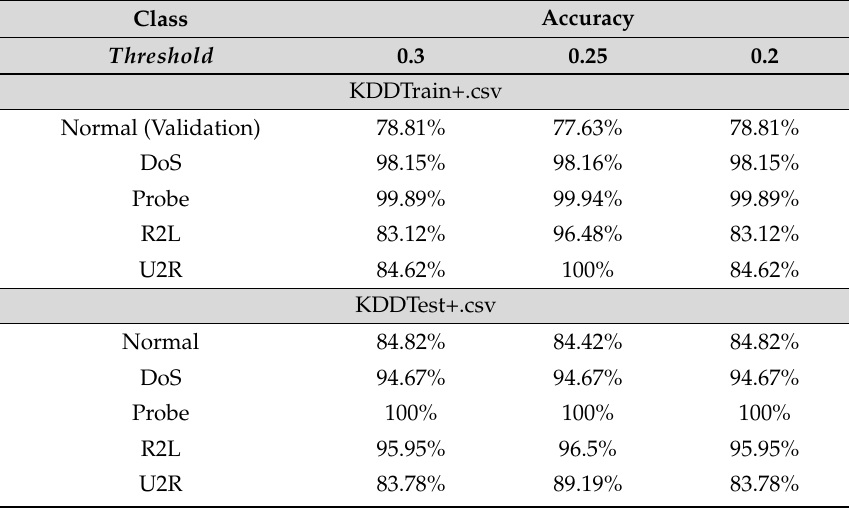
Table 3. NSL-KDD Autoencoder Results.